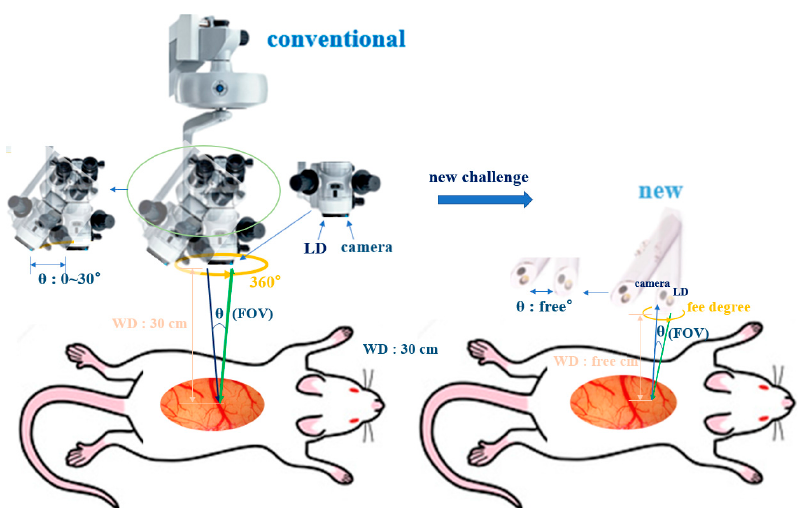
Figure 9. Comparison of performance for surgical microscope and a pen-type